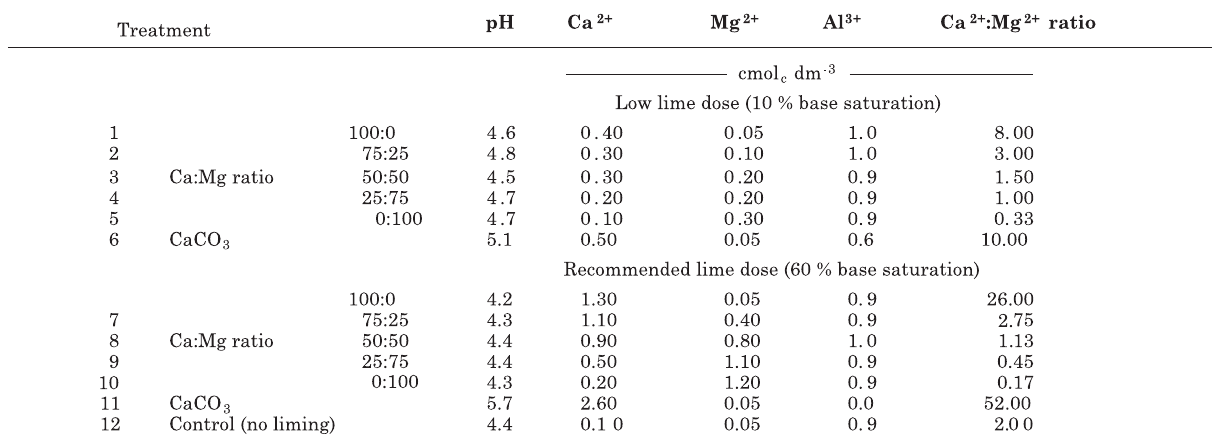
Table 1. Selected chemical characteristics of the soil after establishing the treatments